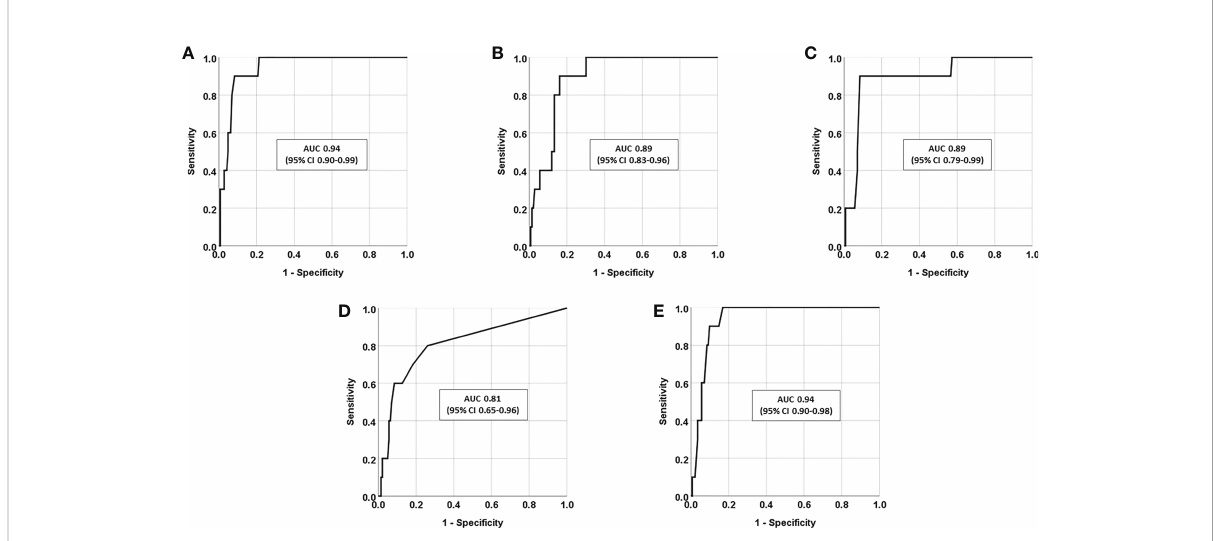
FIGURE 2 Receiver-operating characteristic (ROC) curves presented as area under the curve (AUC) together with 95% con fi dence intervals (95% CI), in patients with adrenal incidentaloma (n=155) for (A) P-cortisol following dexamethasone suppression test (DST), (B) late-night Sa-cortisol (LNSC), (C) late-night Sa-cortisone, (D) Sa-cortisol at 8 a.m. following DST, and (E) Sa-cortisone at 8 a.m. following